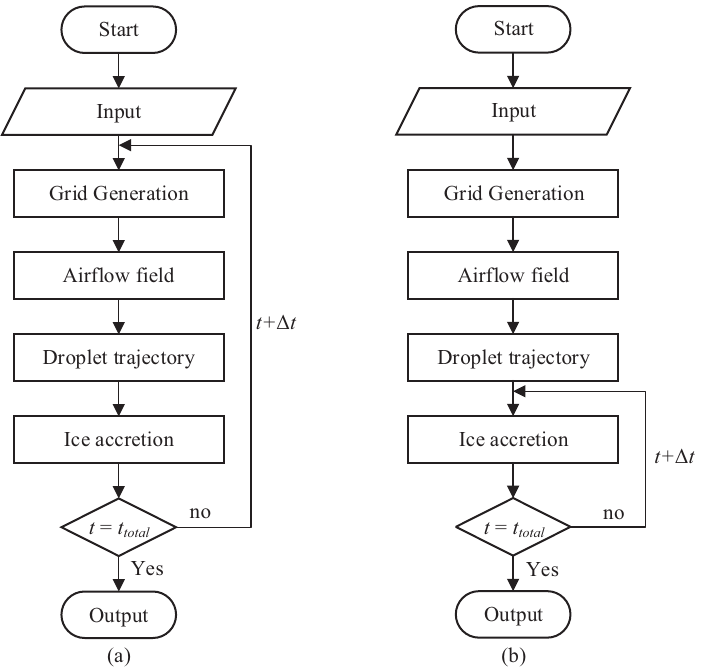
Figure 1. Framework for the quasi-steady icing